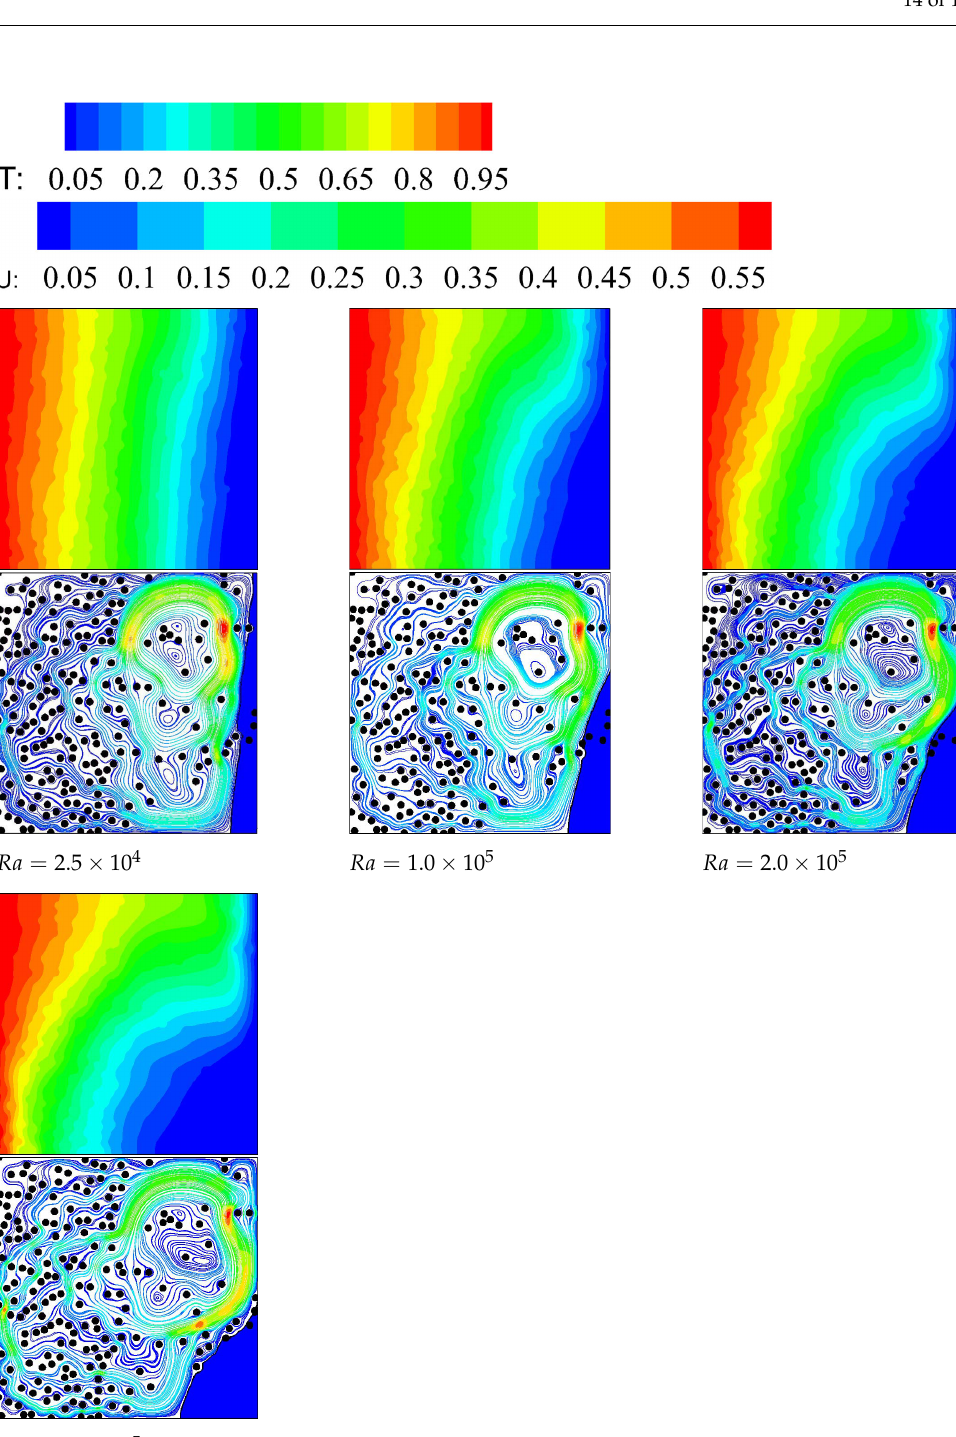
Figure 9. Comparisons of temperature, streamlines and liquid fraction distributions in turning point for positive gradient of case A at Fo = 3.0, in which Ste = 0.1, and Pr =